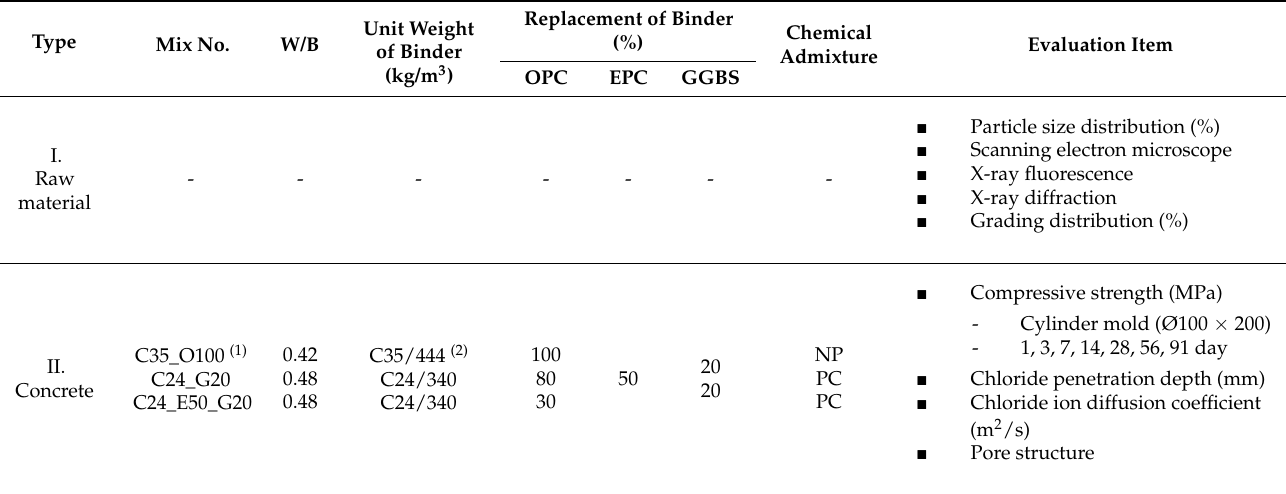
Table 3. Experimental